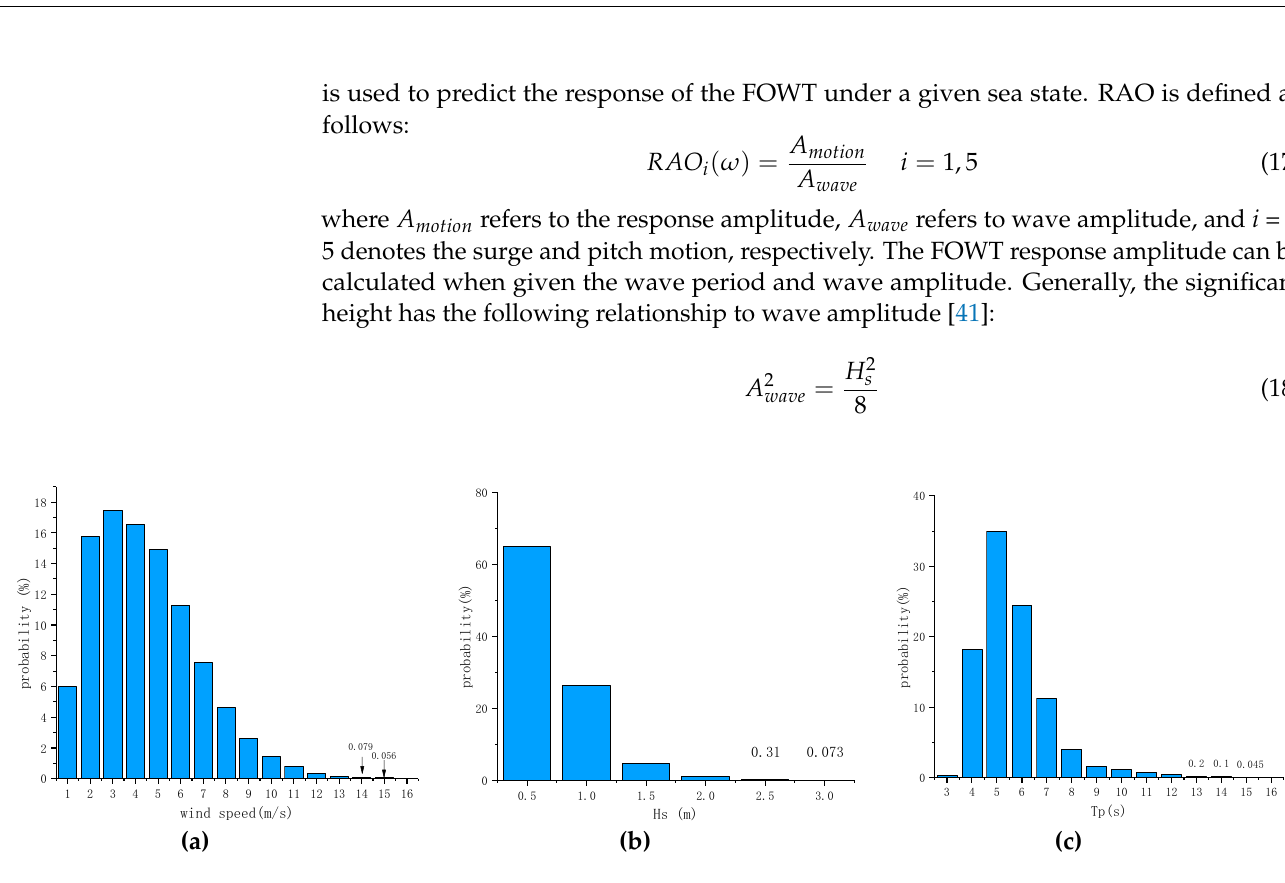
Figure 22. Sea states on Shidao in Shandong province of China. ( a ) Wind speed, v ; ( b ) significant wave height, Hs ; ( c ) wave period, Tp .